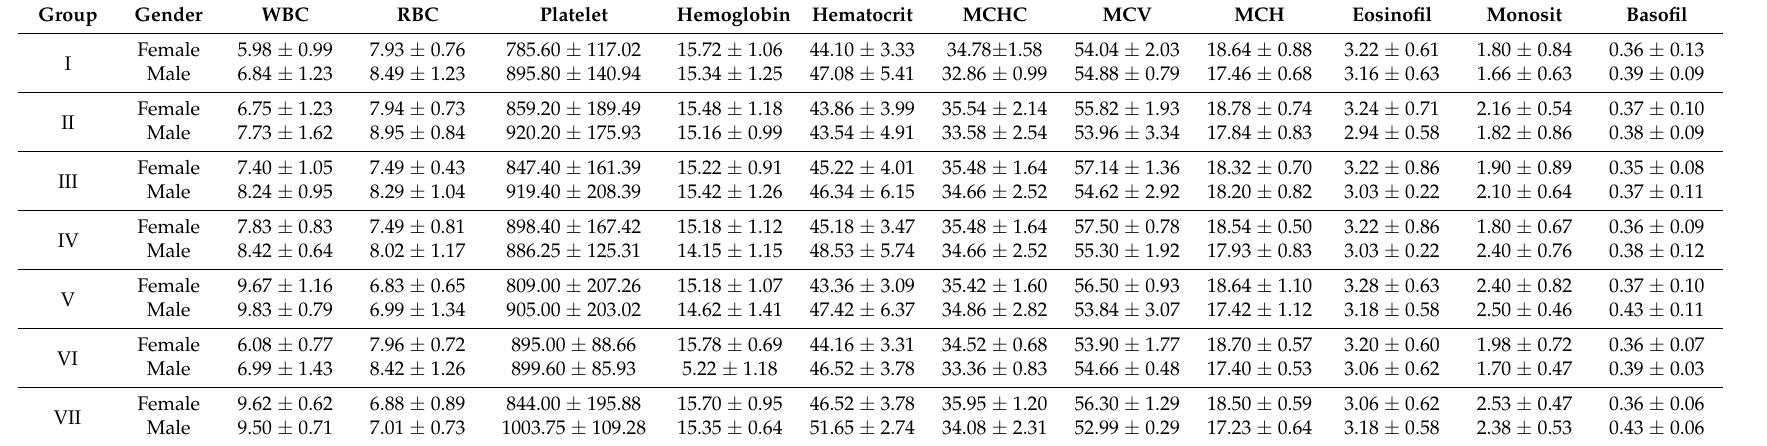
Table 4. Effect of P. fel-terrae leaf extract on hematological parameters (Mean ±